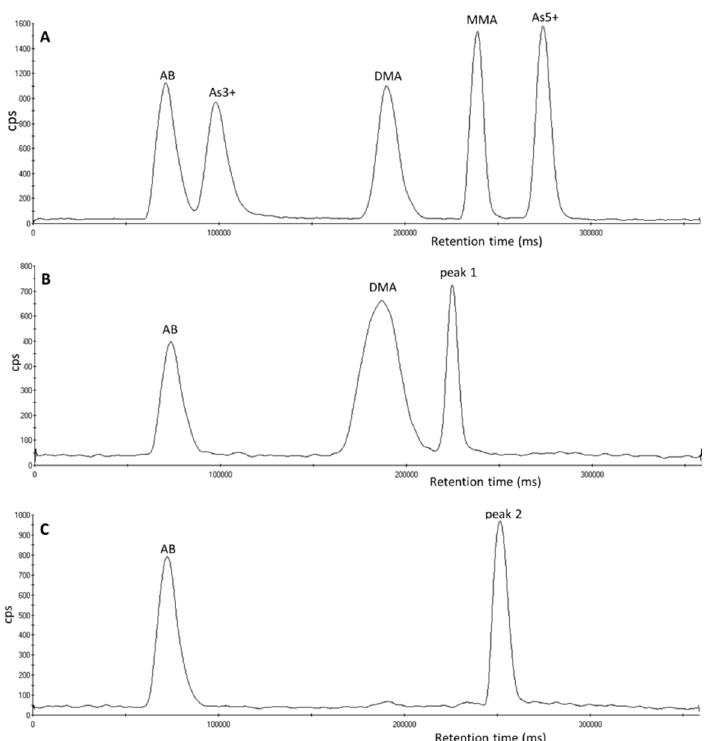
Figure 1. Chromatograms of arsenic species analyzed using an ESI OneFAST system coupled to a Dionex AG7 anion exchange column and ICP-MS using mobile phases 2 mM and 70 mM ammonium carbonate solution ( A ) A 5 µ g L − 1 standard of the five arsenic species. ( B ) A urine sample containing peak 1. ( C ) A urine sample containing peak 2.